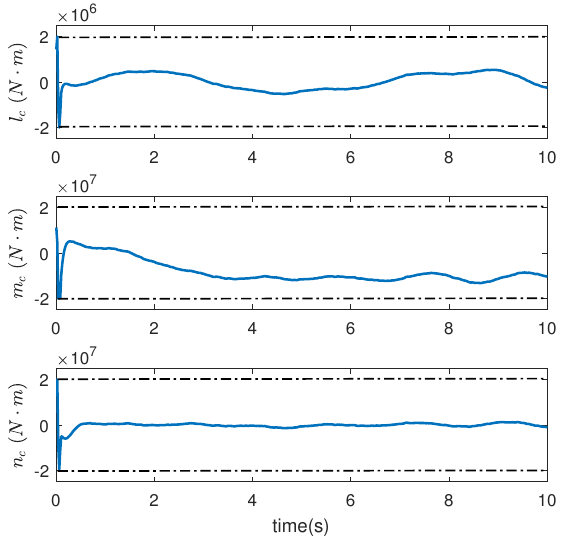
Figure 7. Control input moment response